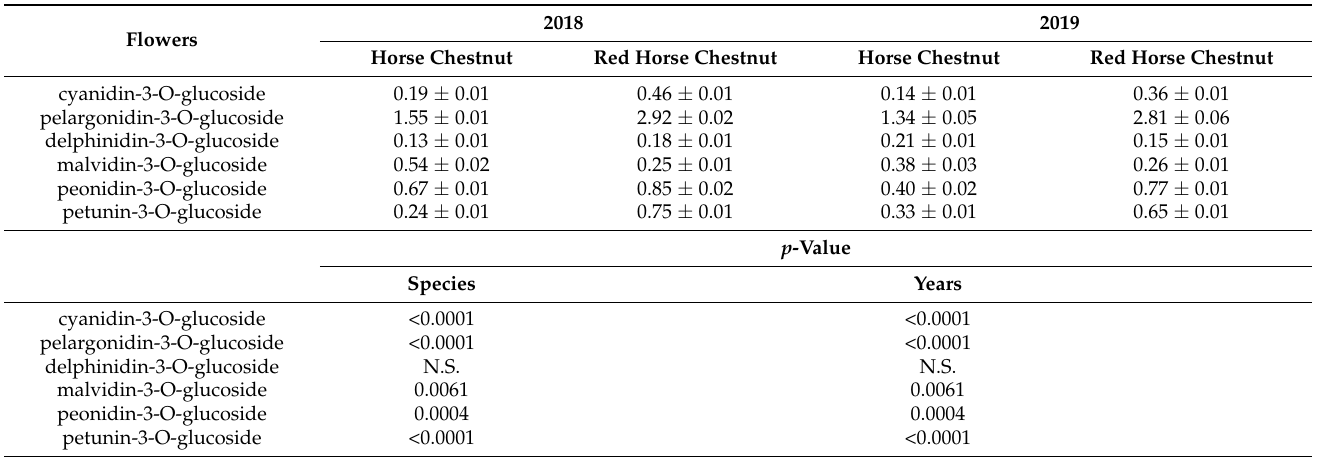
Table 3. Content of identified anthocyanins (mg/g FW) in both species of horse chestnuts’ flowers (mean value ± standard error). N.S (statistically not